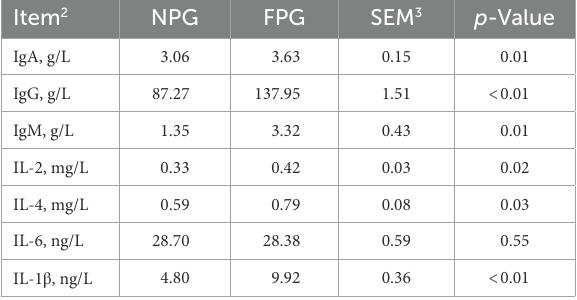
TABLE 8 Effect of fermented feed of Pennisetum giganteum on serum immune parameters of Boer goats in thermal stress 1 . Item